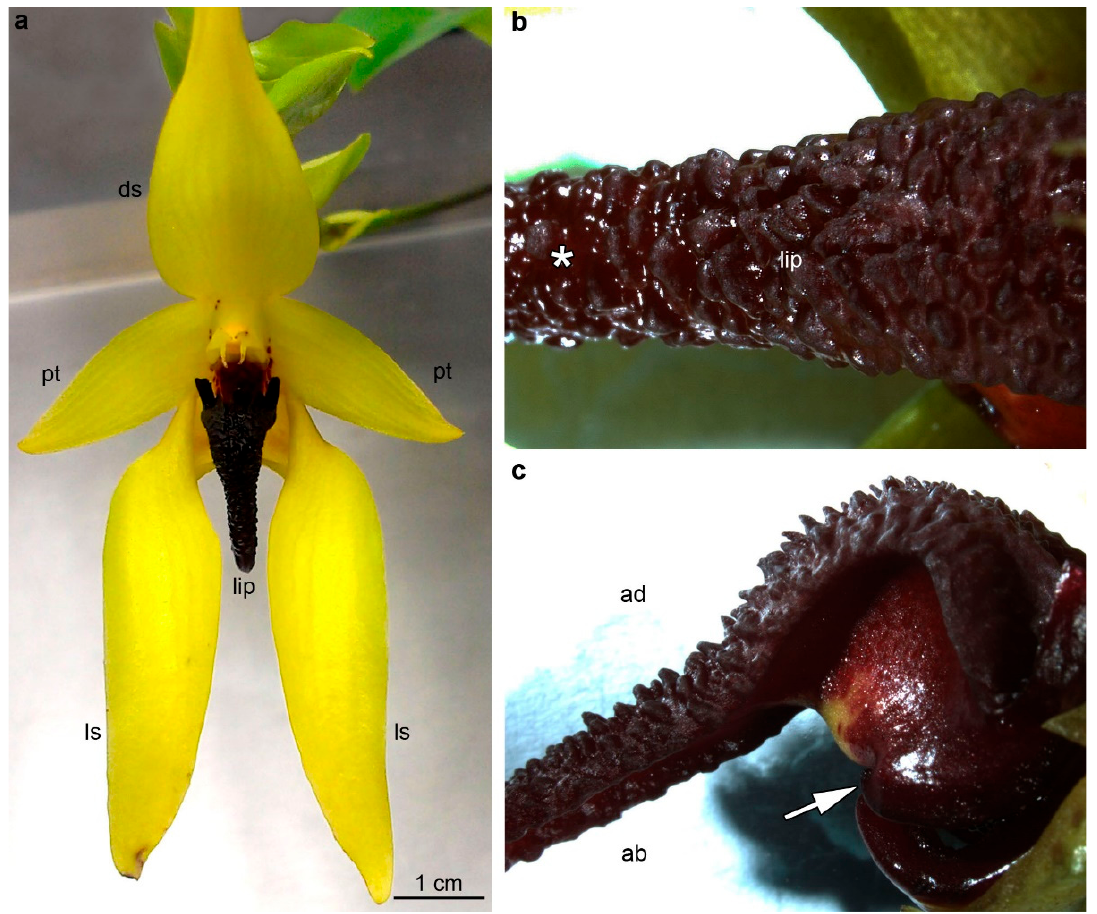
Figure 1. General floral morphology of Bulbophyllum carunculatum . ( a ) Inflorescence. ( b ) Adaxial surface of labellum with glistering secretion (asterisk). ( c ) Lateral view of the lip, the white arrow points to the hinge. ab: Abaxial (outer) surface, ad: adaxial (inner) surface, ds: dorsal sepal, ls: lateral sepal, pt: petal.